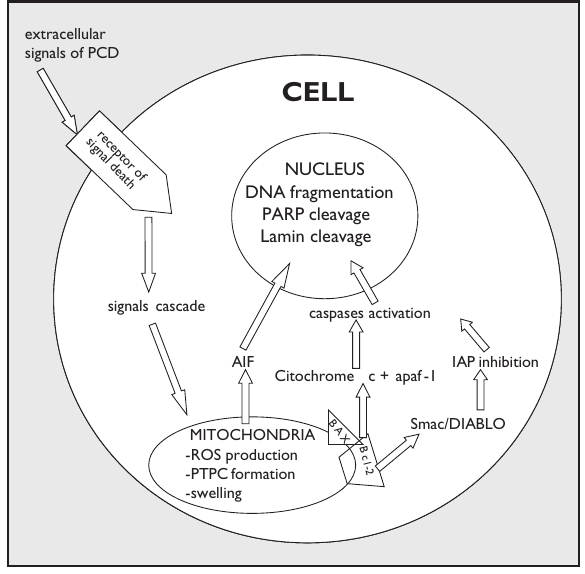
Figure 1 – Schematic representation of the programmed cell death (apoptosis) mediated by mitochondria. Mitochondrial ROS production, PTPC formation, and swelling provoke release of proapoptotic proteins (cyt c, AIF, and Smac/DIABLO) into cytosol. These proteins provoke caspase activation resulting in PARP and lamin cleavage. This event results in the DNA fragmentation